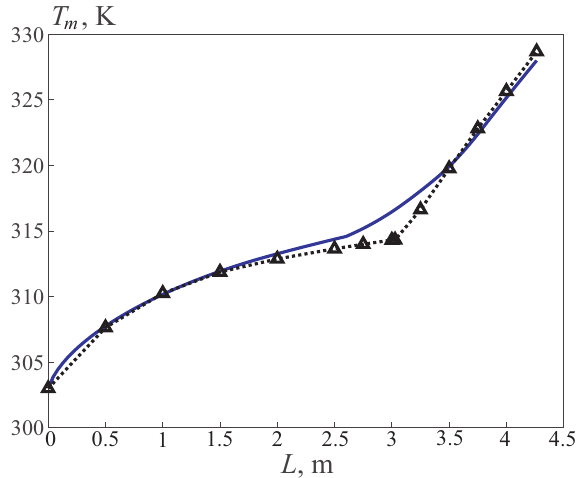
Figure 6. Distributions of the mass average temperature of oil along the length. The solid line corresponds to the results obtained on the basis of the theoretical approach, and the dotted line with triangular marks corresponds to the results of numerical